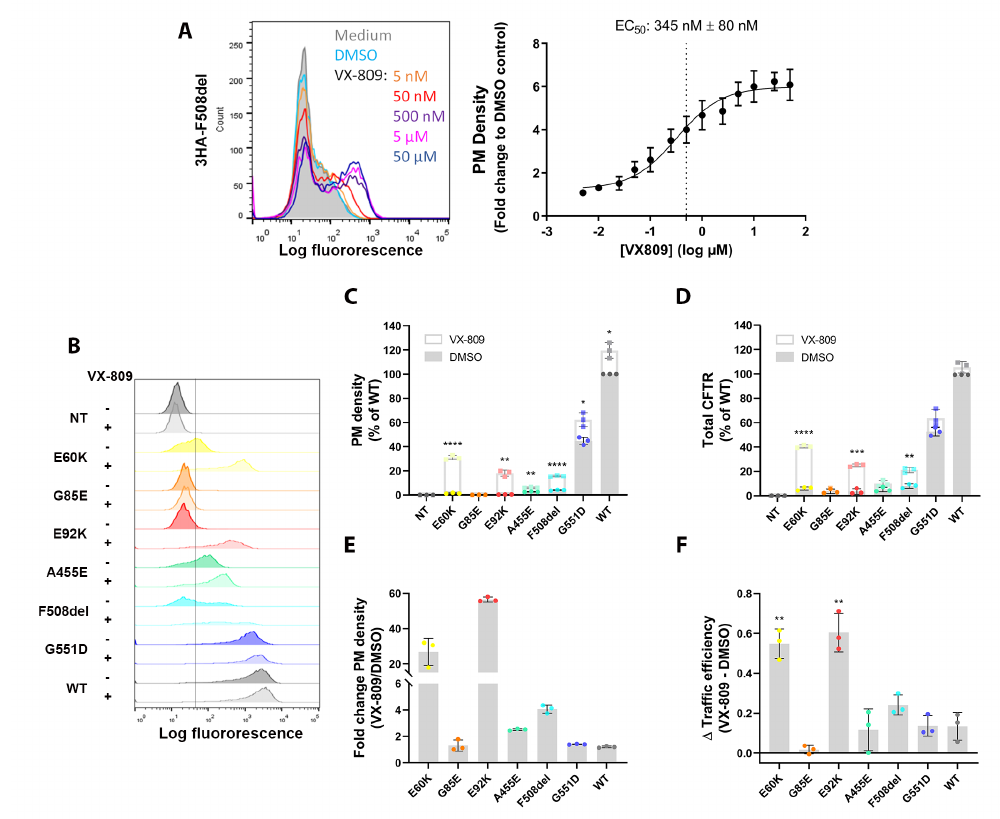
Figure 5. Quantification of plasma membrane density and tra ffi c e ffi ciency by flow cytometry of CFTR mutants. ( A ) 3HA-F508del-CFTR HEK293T cells were treated with increasing amounts of corrector VX-809 (range 5 nM–50 µ M) or DMSO for 24 h and analyzed by flow cytometry. Left: Representative histograms of di ff erent VX-809 concentrations and their corresponding PM density levels is given. Right: EC 50 determination of the dose-response to VX-809. Mean ± S.D. of n = 3 independent experiments. ( B ) Representative histograms of the PM density of the di ff erent 3HA-tagged